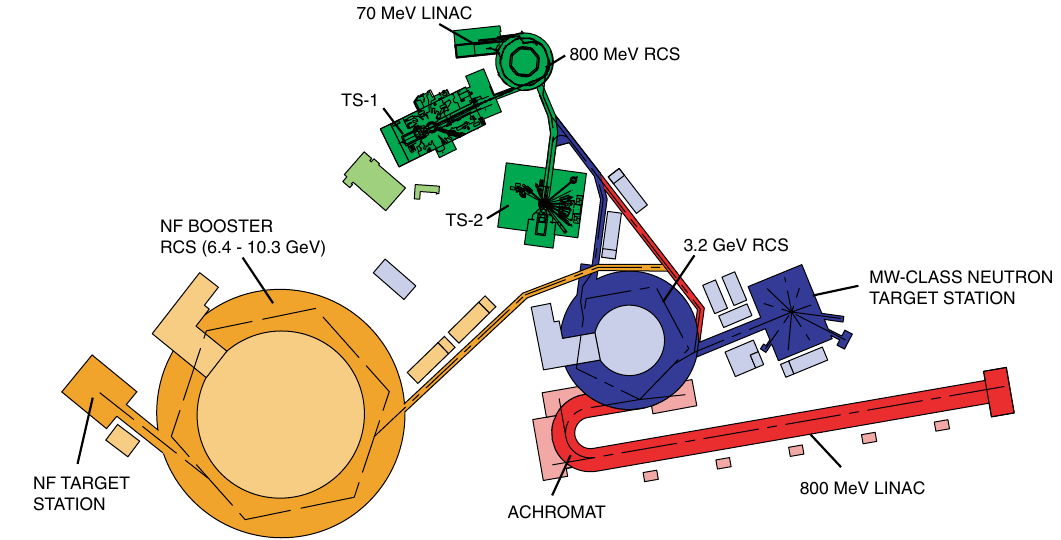
FIG. 5. Conceptual layout of the NF proton driver with ISIS (green), (cid:5) 3 : 2 GeV RCS (blue), 800 MeV linac (red), and dedicated NF booster (orange) within the RAL site